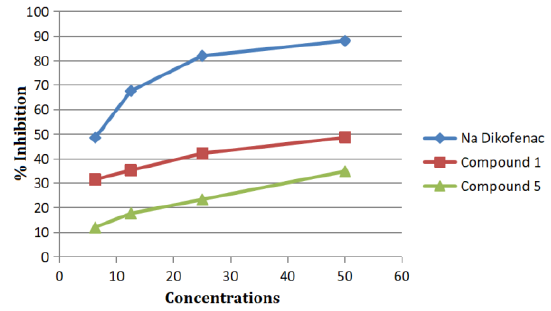
Figure 7. The antidenaturation activity of 1 and 5